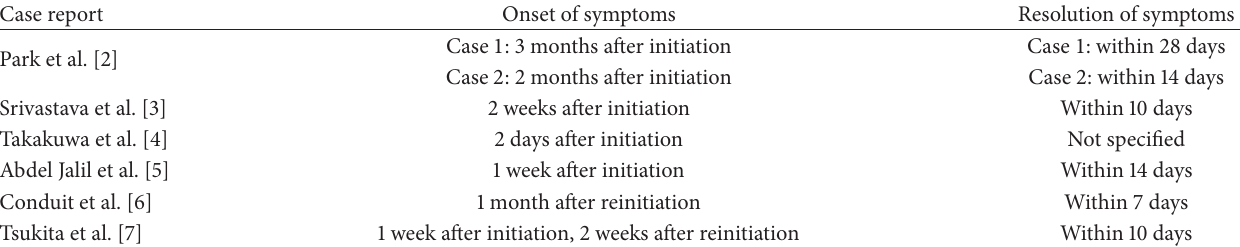
Table 1: Timing of onset and resolution of symptoms after initiating and discontinuing crizotinib therapy in six previous case